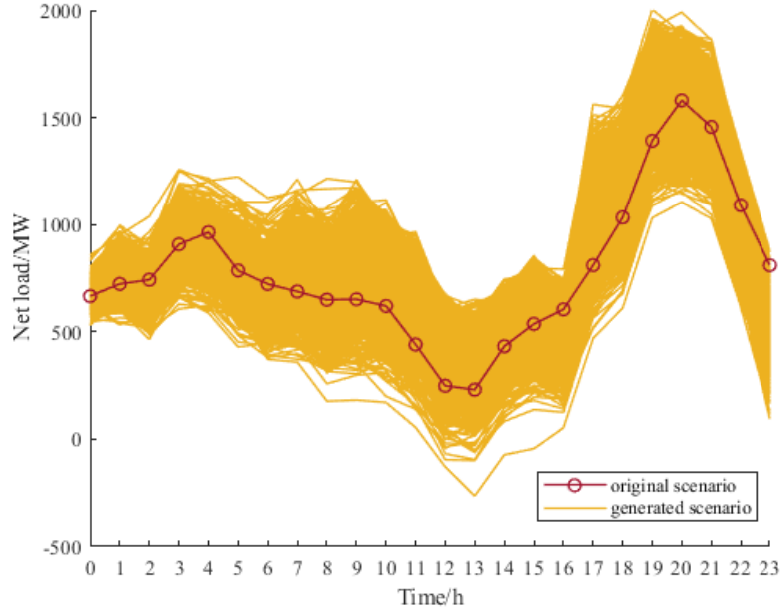
Figure 7. Results of scenario generation.